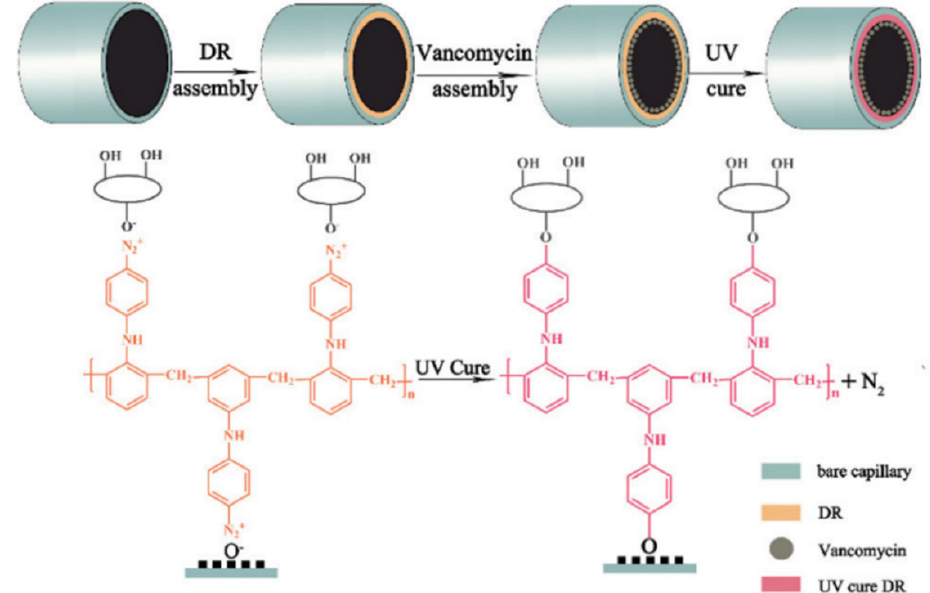
Figure 3. Preparation of the diazo resin (DR)/vancomycin coatings on the inner wall of the column (reprinted from Publication Xing, J.; Wang, F.; Cong, H.; Wang, S.; Shen, Y.; Yu, B., Analysis of proteins and chiral drugs based on vancomycin covalent capillary electrophoretic coating. Analyst . 2021, 146, (4), 1320–1325. Copyright © 2021, with permission from Royal Society of Chemistry [47]).